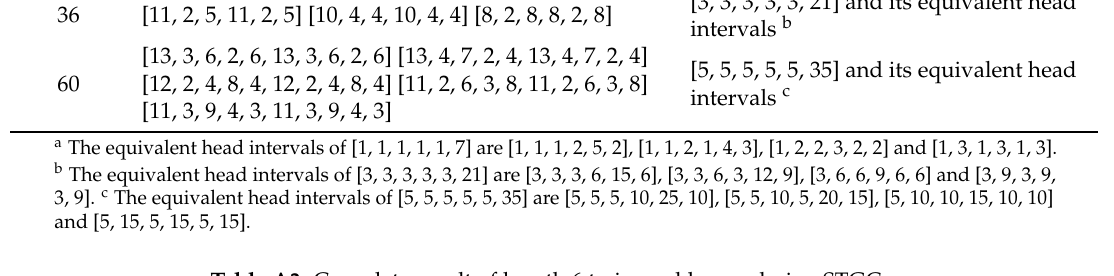
Table A3. Complete result of length 6 twin-necklace ordering STGCs.